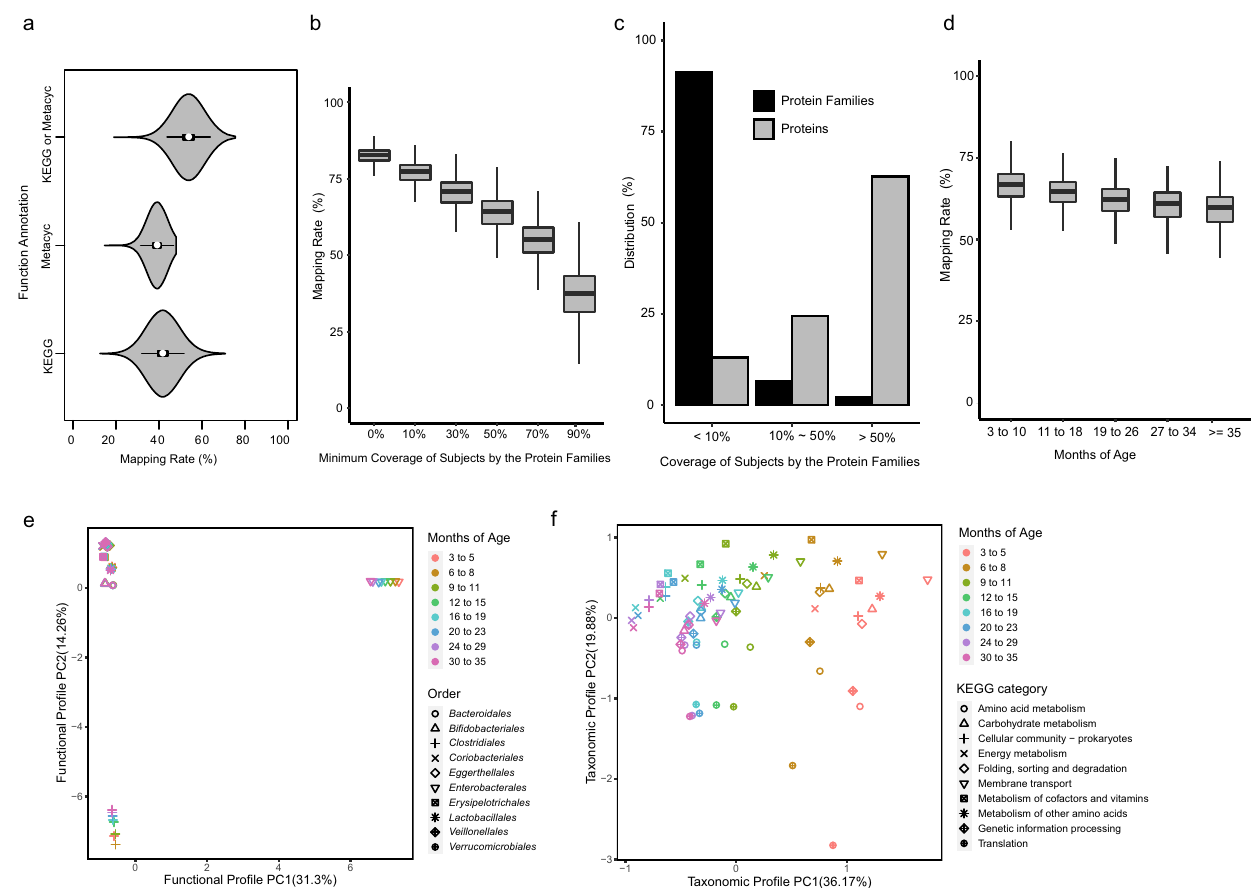
Fig. 3 Construction of protein core families from human gut microbiota. a Mapping rates of metagenomic reads onto protein-coding genes with functional annotations. Violin plots show the distributions of annotation mapping rates across samples ( n = 12,854 metagenomic sequencing runs). Over half of the genetic potential in a sample have functional annotations from MetaCyc or KEGG. Violin plots indicate median (white dot), the fi rst and third quartile (black bar in the center), and the 1.5X interquartile ranges (black lines stretched from the bar). b Mapping rates of metagenomic reads onto protein families present in more than certain percentages of subjects in each metagenomic sequencing run ( n = 12,854). All protein families (0% on the x-axis) accounted for 82.4% of the metagenomic reads. The core protein families were de fi ned to be families found in >50% of subjects (50% on the x-axis), which accounted for 63.6% of the metagenomic reads. c Distribution of proteins across protein families. The core protein families in >50% of subjects represented 2.2% of all families, but included 62.7% of all proteins. The peripheral protein families in less than 10% of subjects represented 91.2% of all families, but included only 13% of all proteins. d Mapping rates of metagenomic reads onto the core protein families across the following developmental stages de fi ned by the months of age: 3 to 10 ( n = 4,645), 11 to 18 ( n = 3,634), 19 to 26 ( n = 2,252), 27 to 34 ( n = 1,385), and ≥ 35 ( n = 938). The mapping rates only decreased slightly as the subjects matured and their microbiomes diversi fi ed. e Principal component analysis (PCA) of the functional pro fi les of major orders over time. The functional pro fi le of an order is the gene abundances of core families in this order in every KEGG category. f PCA of the taxonomic pro fi les of KEGG categories over time. The taxonomic pro fi le of a KEGG category is the gene abundances of core families in this KEGG category in every order. Boxplots show the median (center), the fi rst and third quartile (box), and 1.5X interquartile ranges (whiskers). Source data are provided as a Source Data fi